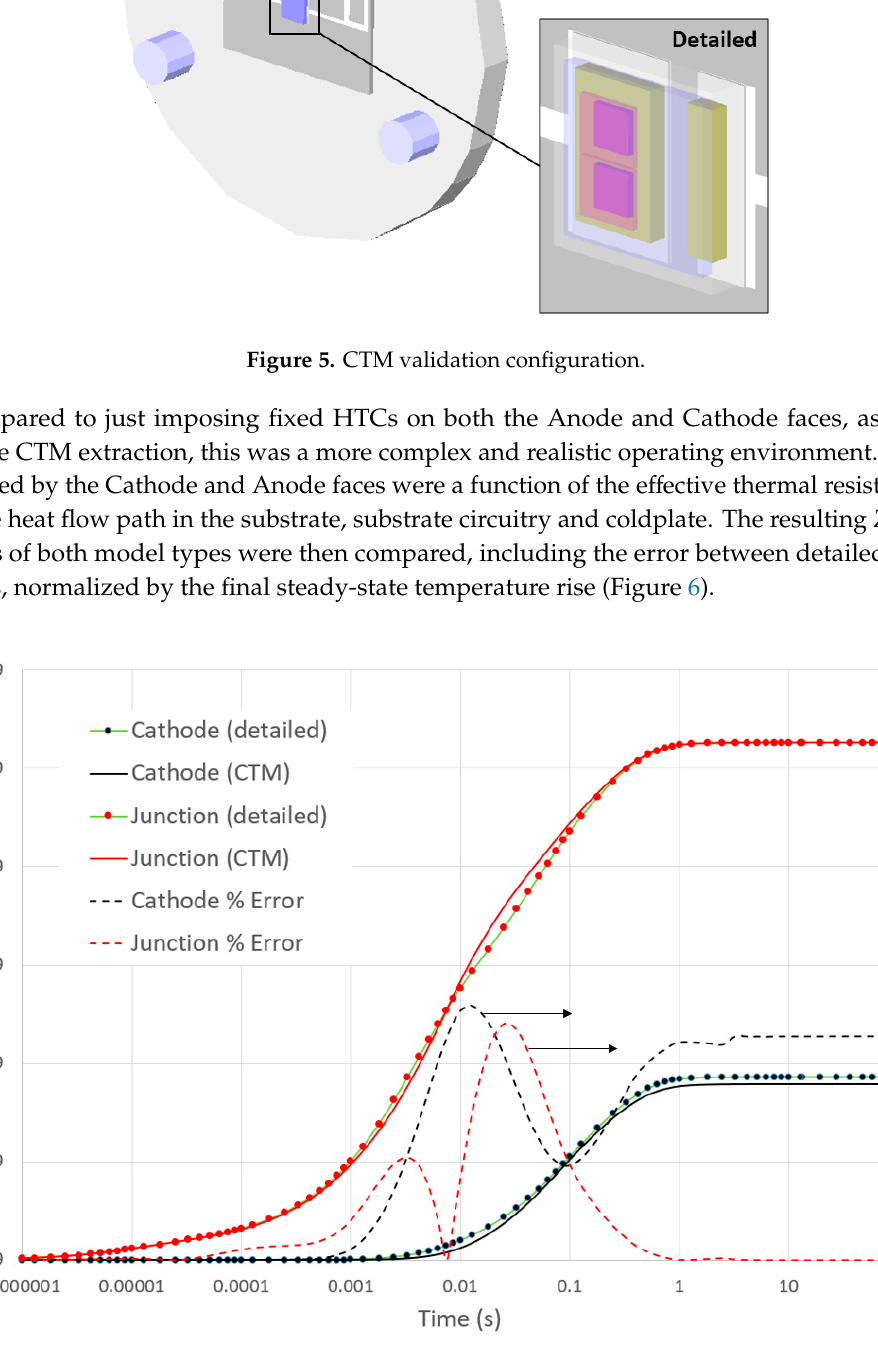
Figure 6. CTM vs. detailed error comparison for both Junction and Cathode thermal responses.